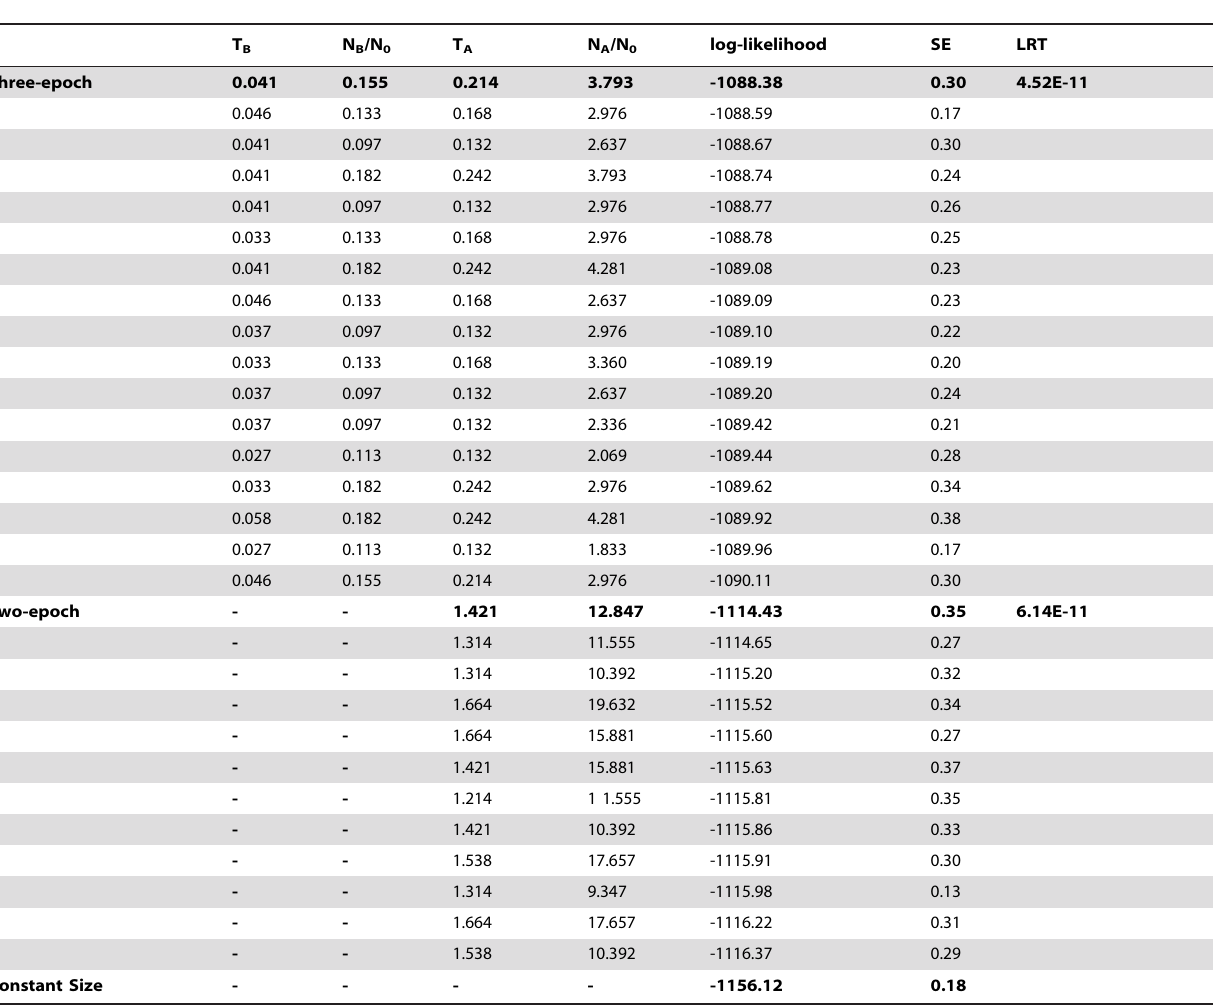
Table 1 . Fitted model likelihoods for neutral, two-epoch and three-epoch demography models (see parameter meaning in Figure